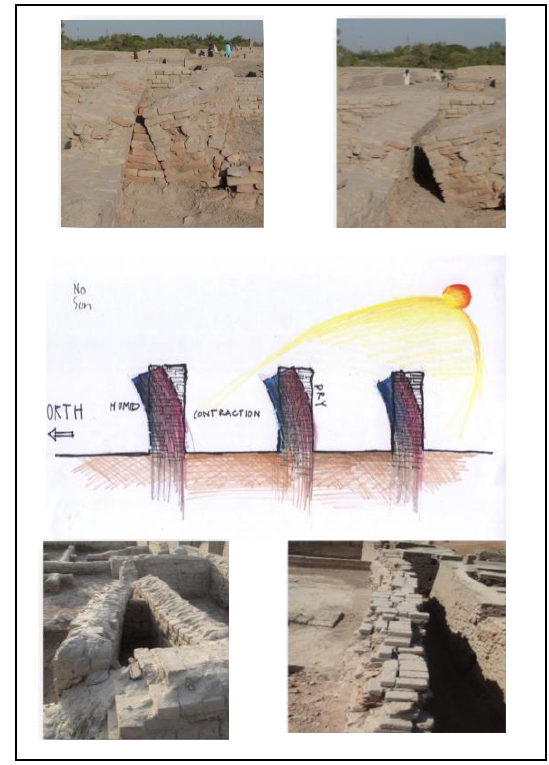
Figure 1. The thermal stress recorded and filling of gaps, voids in mud capping with pure clay in DK